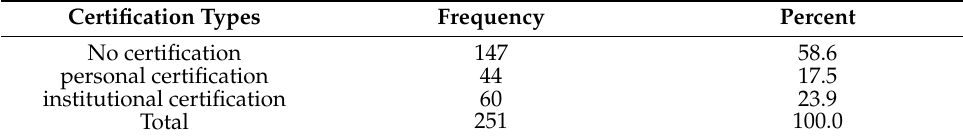
Table 6. Uploader certification type distribution.